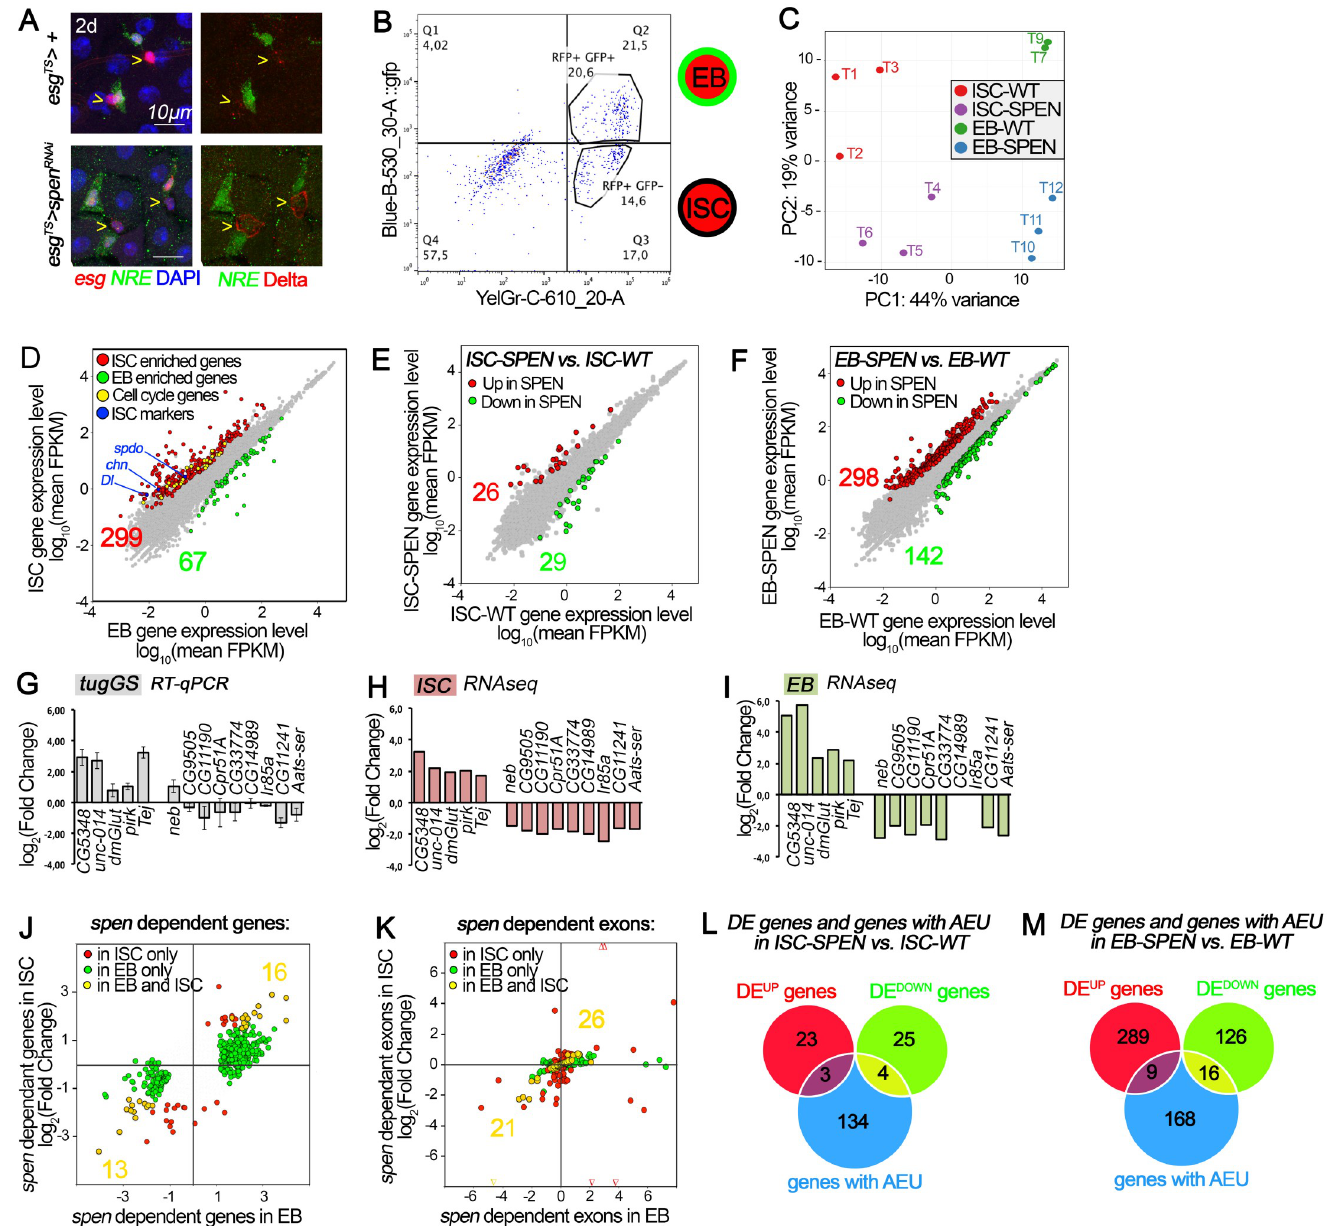
Fig 5. spen -dependent transcript identification by RNAseq analysis from two-color FACS sorted ISC and EB . (A) ISCs and EBs were sorted using a two-color FACS sorting approach following 2 day expression using esgGAL4 , Gal80ts to drive UAS-RFP expression in both cells, and NRE-Venus (GREEN) to mark only EB cells (EC precursors). Wild-type controls (top panels) showed vesicular Dl staining in esg+ NRE- cells, spen RNAi (bottom panels) showed membrane accumulation of Dl in esg+ NRE- cells. Scale bar: 10 μ m. (B) Flow cytometry analysis of ISC and EB sorting. The scatterplot revealed two distinct populations: RFP positive (ISCs) and RFP and GFP positive EBs cells. (C) Principal component analysis (PCA) based on the 300 top genes with the highest variance clustered our samples in to four distinct groups. (D) Differential gene expression comparison between WT ISCs and WT EBs revealed 366 differentially expressed genes, FDR of 0.05. Genes significantly enriched in ISC (RED), genes significantly enriched in EB (GREEN), known ISC markers (BLUE), cell-cycle related-genes (YELLOW). (E) Differential gene expression comparison between WT vs . spen RNAi expressing ISCs or (F) EBs; FDR of 0.05. ( G-I ) RT-qPCR validation of spen- dependent genes from whole midguts that expressed ubiquitinously spen RNAi during 2days (tubGS ), differentially expressed in RNAseq data from (H) ISCs and (I) in EBs. (J) Comparison of spen - dependent differentially expressed (DE) genes between ISCs and EBs. ( K ) spen -dependent differentially used exons. Arrowheads represent exons that are out of the axis range. (L, M) Overlap between differentially expressed (DE) genes and genes with alternative exon usage (AEU) in absence of spen in ISCs, or (L) in EBs ( M ).